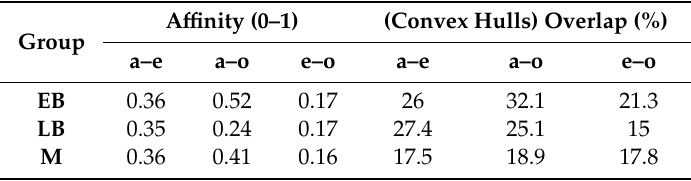
Table 3. A ffi nity scores and proportion overlap (convex hulls) for / a e o / in the narrative. Results displayed by group (Early Bilinguals (EB), Late Bilinguals (LB) and Monolinguals (M)). A ffi nity Group